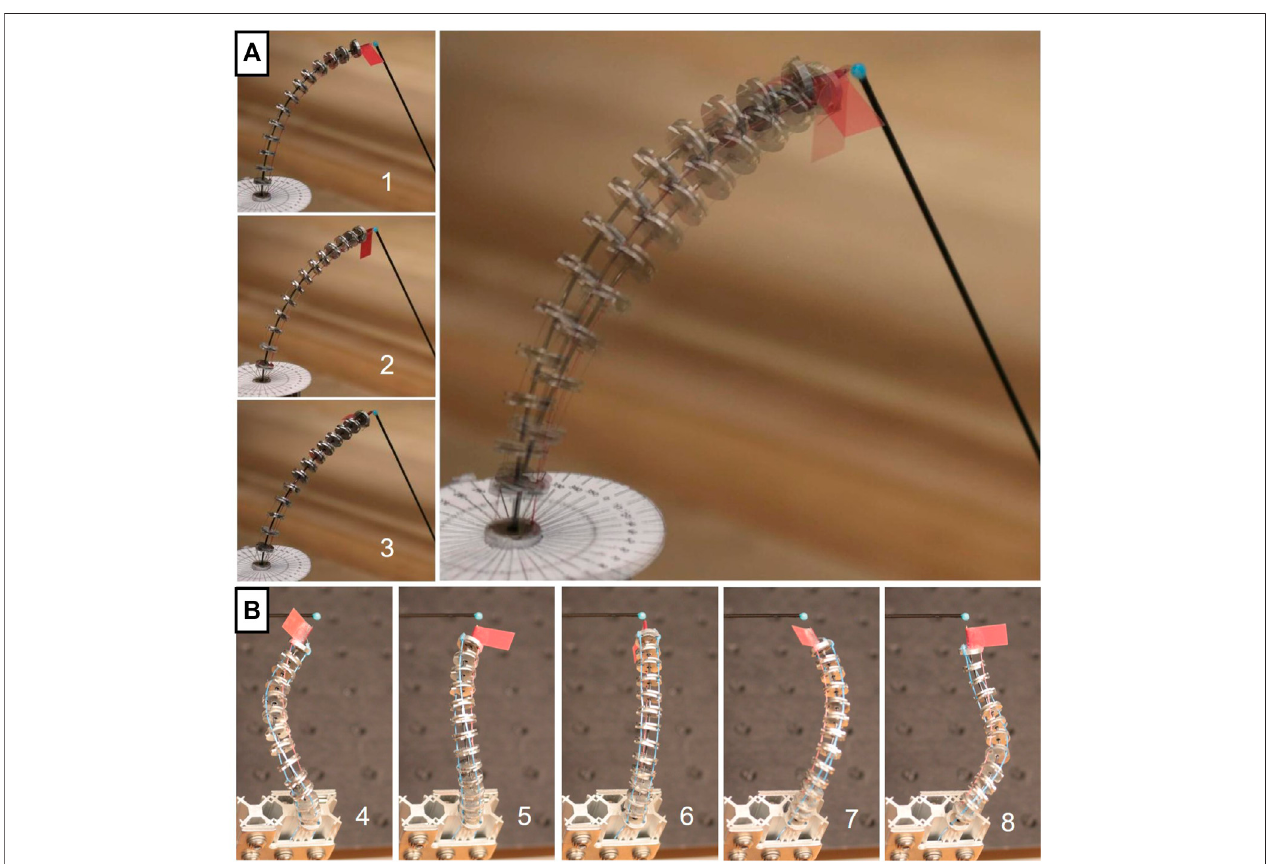
FIGURE 9 | Motion capabilities indicated by position redundancy. The red fl ag with fl agpoles of 7 mm indicates, on the one hand, the orientation of the end disk aroundthetangentvectorofthebackboneand,ontheotherhand,therotation α ofthebackbone. (A) (Leftcolumn)Con fi gurationswithsigni fi cantbackbonerotationand negligibletranslation,see Table3 .(Right)Overlayofallcon fi gurations.Theaccompanyingvideoprovidesadditionalvisualaid. (B) Moreextremecon fi gurations,requiring backbone translation.